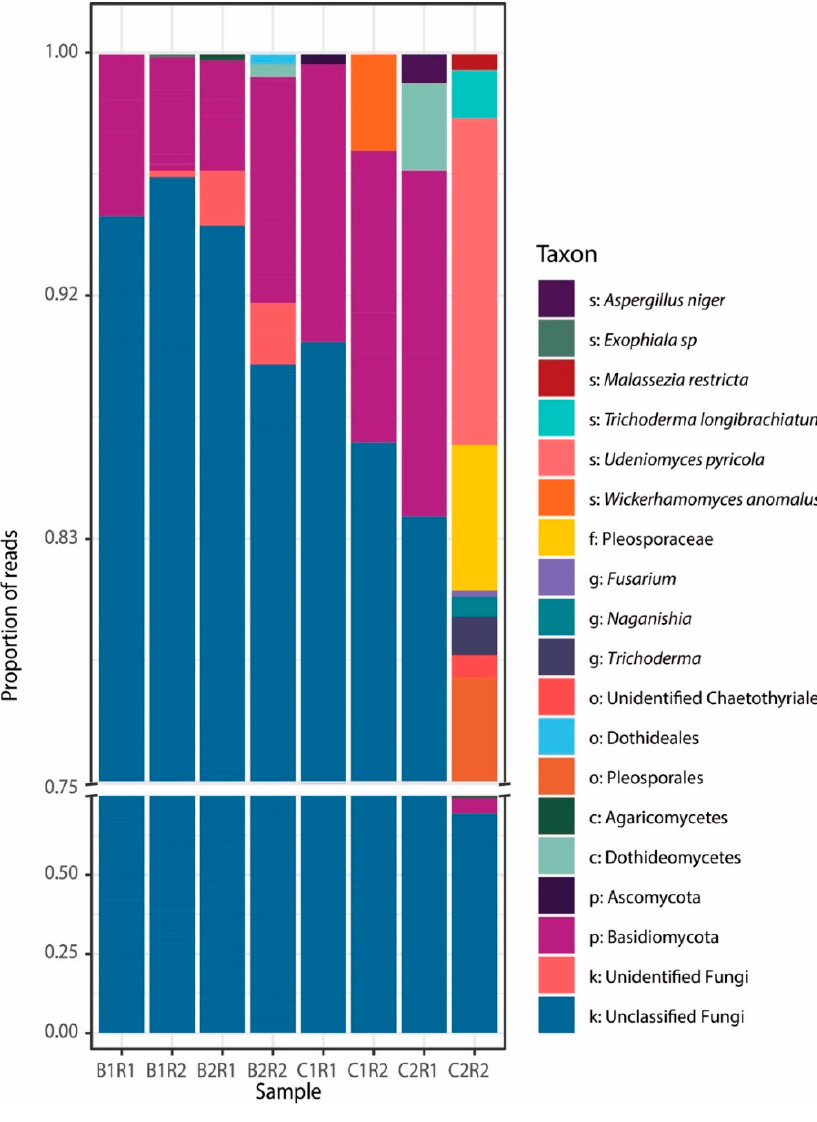
Figure 5. Stacked bar plot showing the relative abundance of fungal taxa at the lowest taxonomic levels identified in each deep-sea sediment sample collected in the Ross Sea. Taxonomic affiliation was assigned using a confidence threshold cutoff of 0.8.